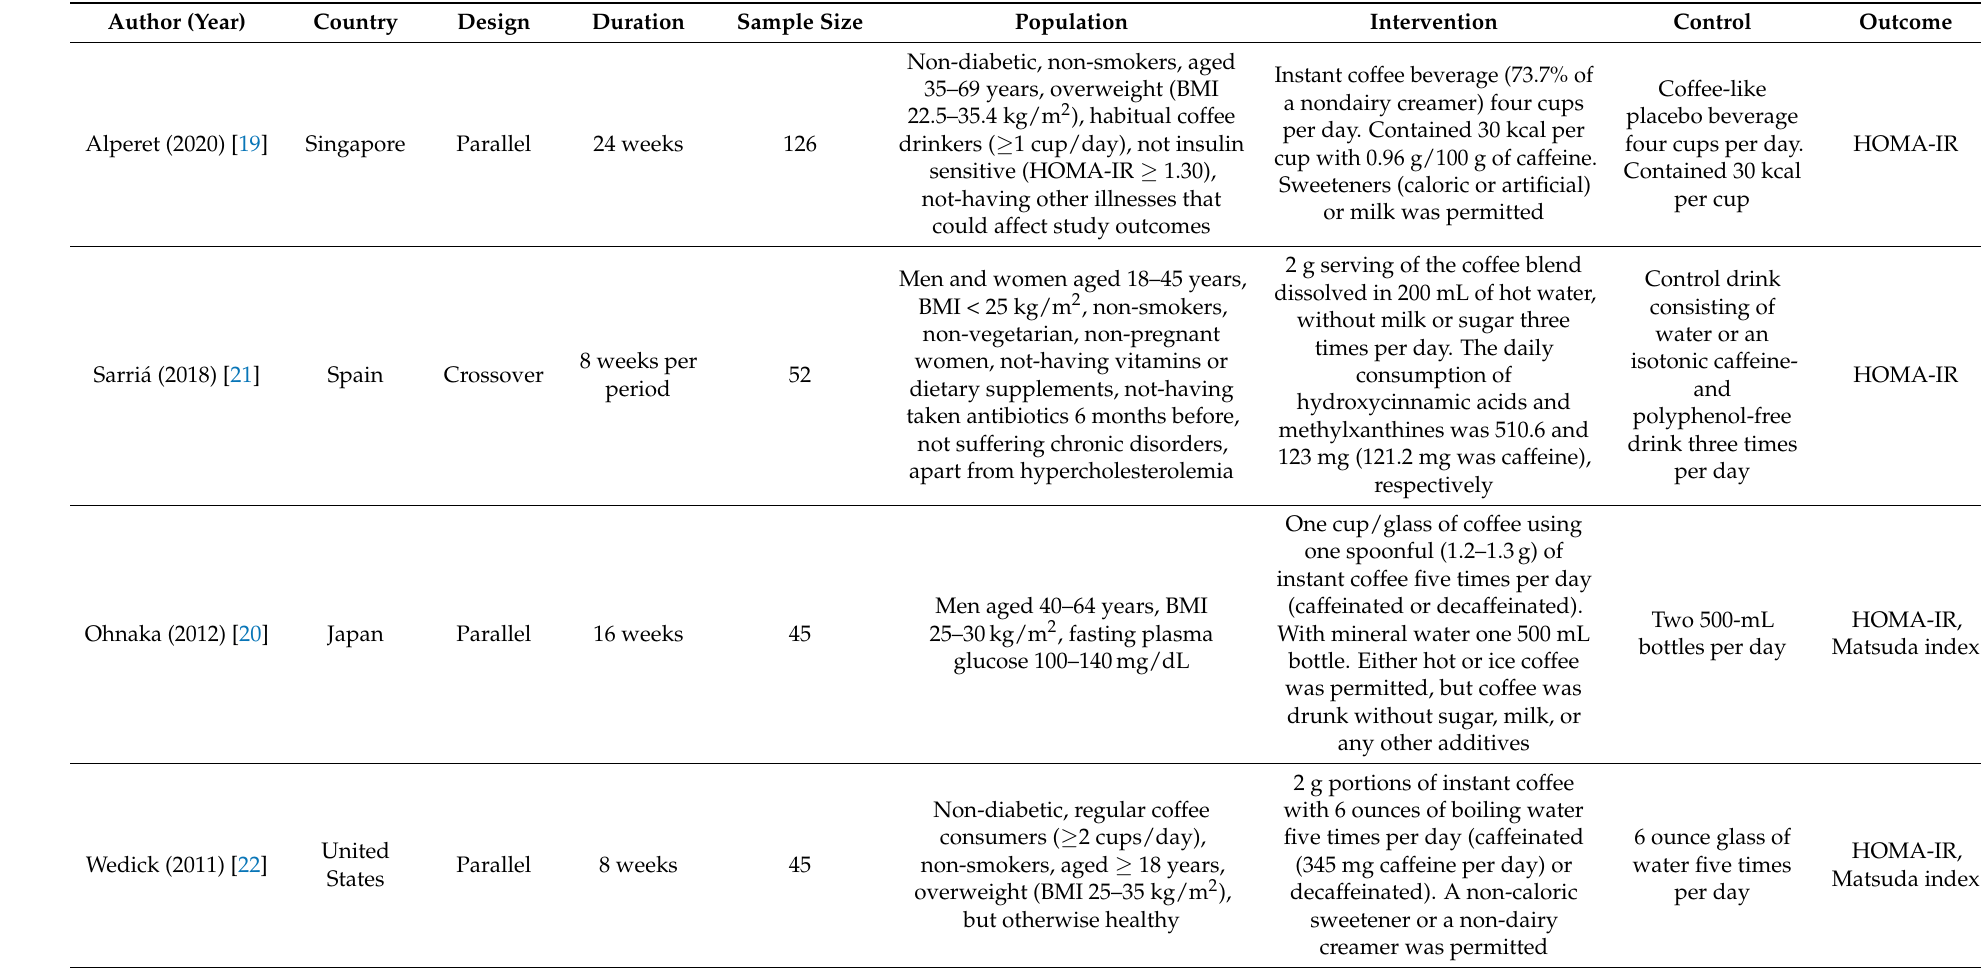
Table 2. Characteristics of selected